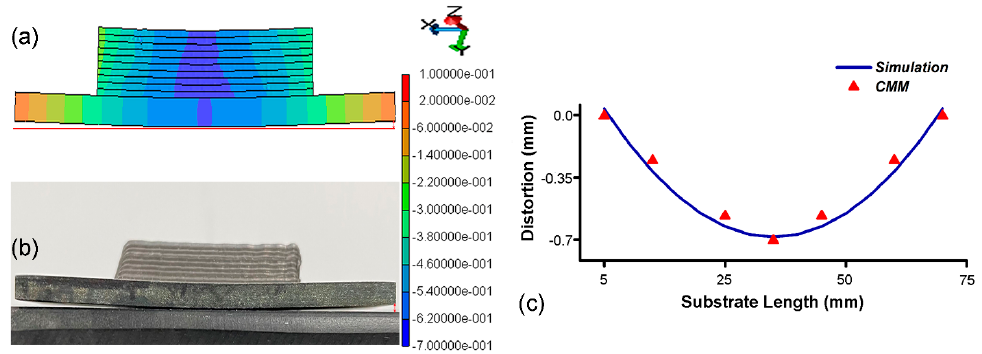
Figure 12. ( a ) Distortion prediction through a hybrid FEM scheme. ( b ) Experimentally determined distortion. ( c ) Comparison of FEM and CMM results.